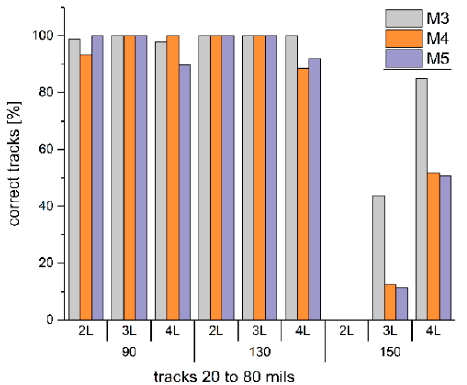
Figure A1. Experimental set up used for X force and acquiring data during the soldering characterization.